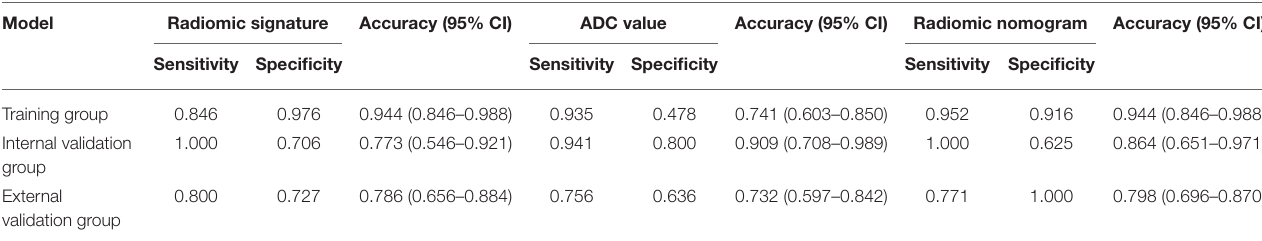
TABLE 3 | Predictive performance of the radiomic signature and radiomic